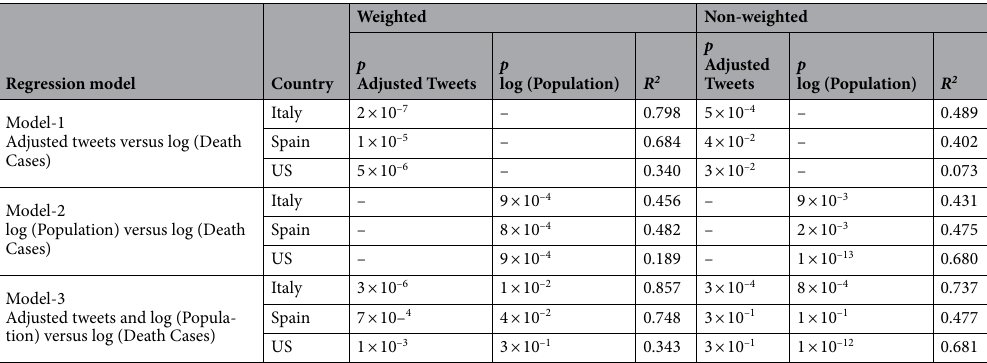
Table 1. Per country coefficient significance and R2 values for weighted and unweighted regression models. Regression models explored: tweets intensity versus log death cases; log population versus log death cases and; tweets intensity and log population versus log death cases.